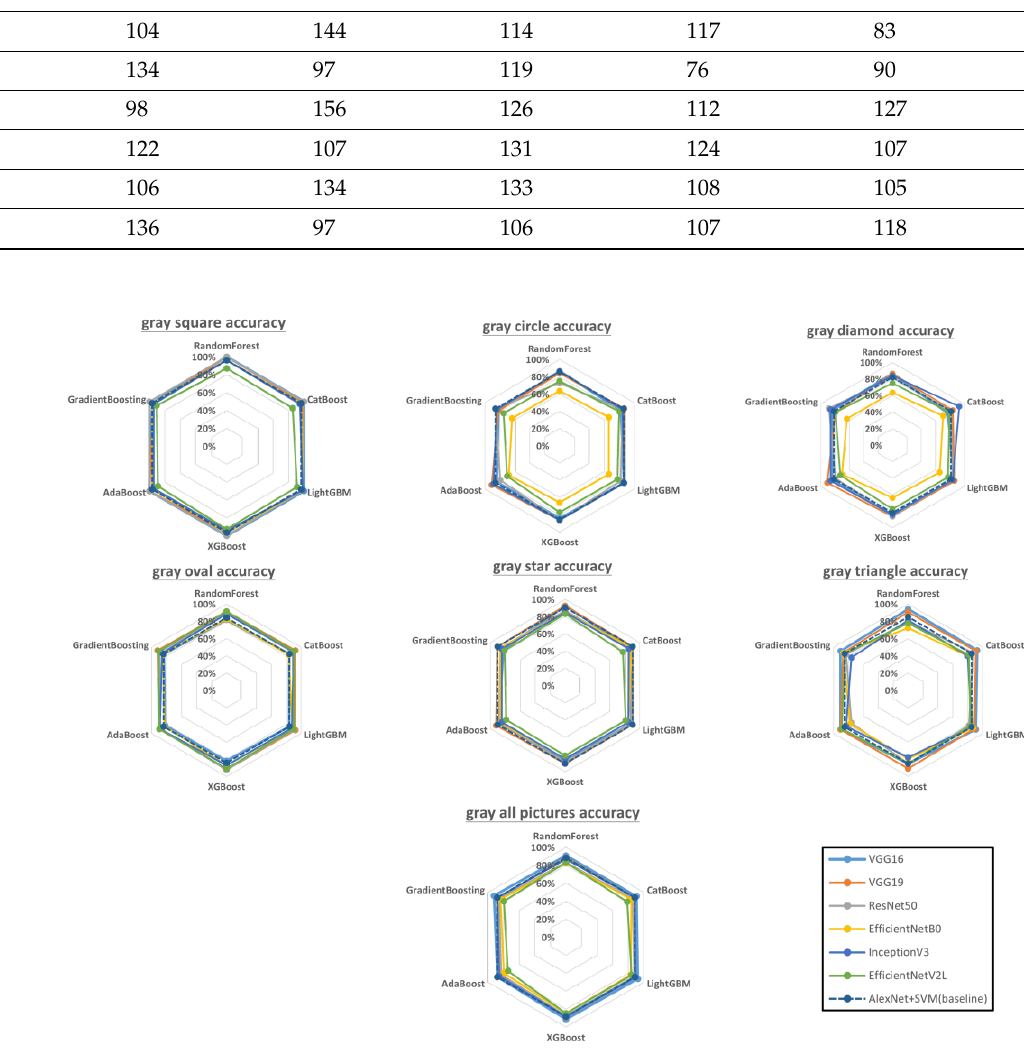
Figure 10. Accuracy of each model combination for gray-colored geometries (raw data are presented in Appendix A). The dotted regular hexagon is the baseline using AlexNet with SVM.